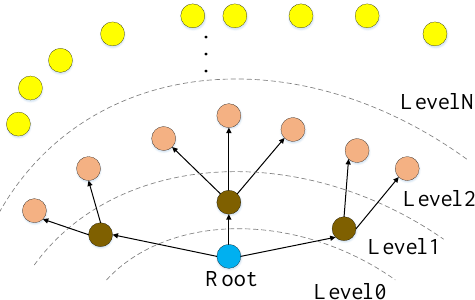
Figure 20. Spanning-tree based multi-hop synchronization forming a hierarchical tree of the nodes starting from the root